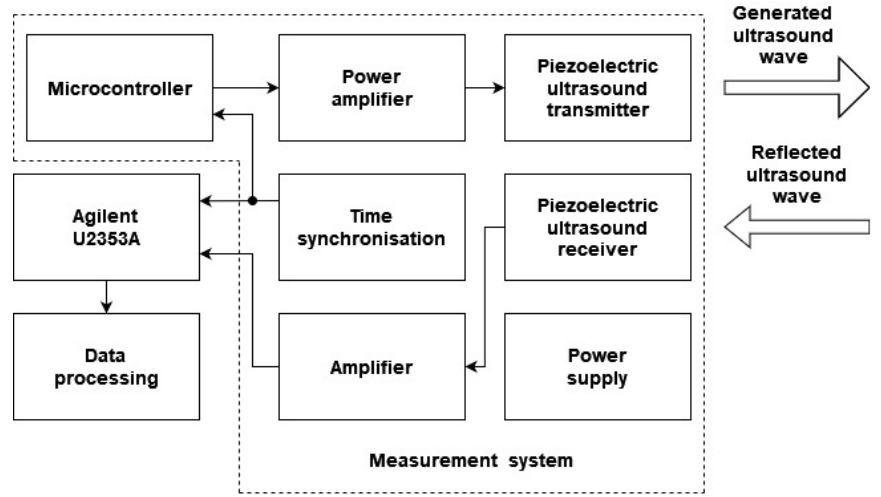
Figure 1. Diagram of the measurement system.